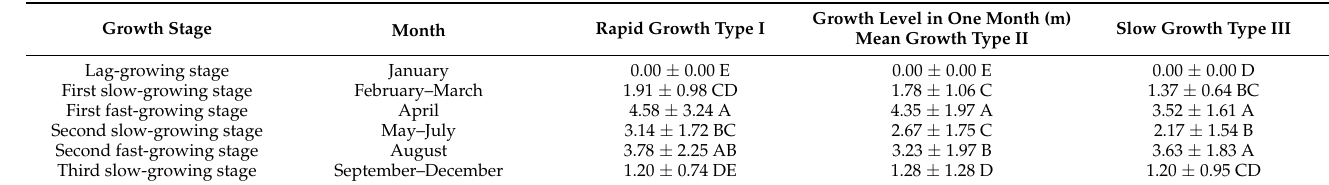
Table 6. Growth stage divisions of DBH for three growth types in C. axillaris .